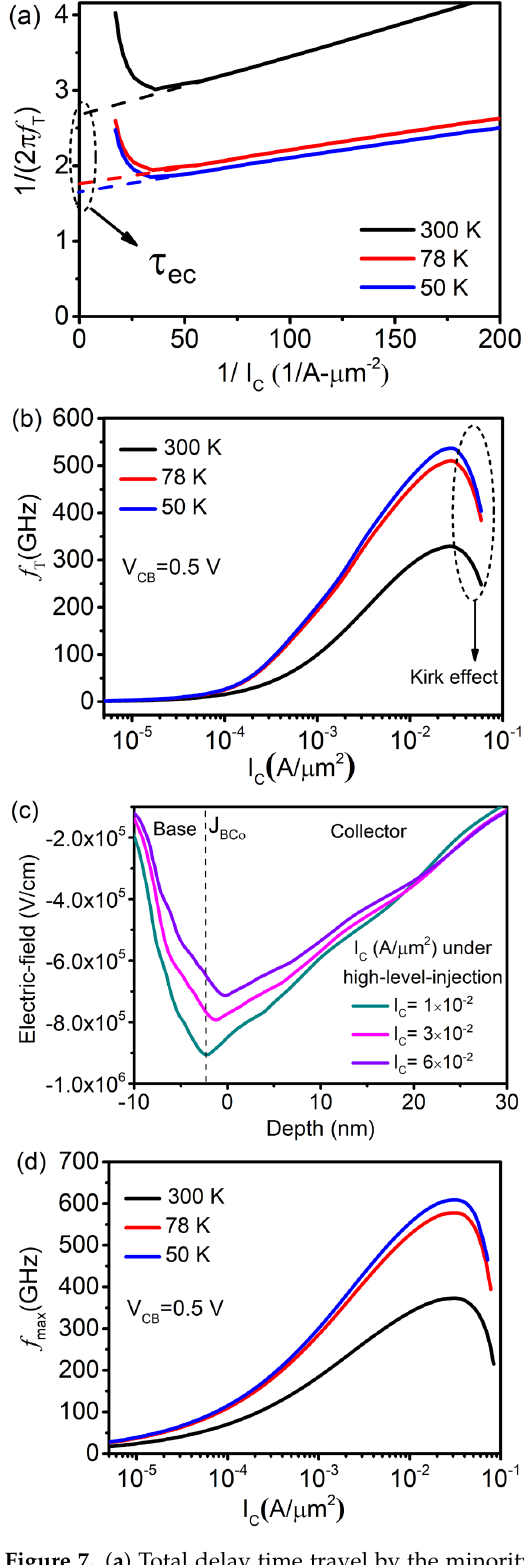
Figure 7. ( a ) Total delay time travel by the minority charge carrier (1/2 π f T ) vs. 1/ I C . The τ ec is extracted with extrapolation of the linear part intersecting at 1 /I C = 0; ( b ) f T (GHz) versus I C ( A/µm 2 ); ( c ) e lectric− field profile at the CB junction at high I C ; and ( d ) f max (GHz) versus I C ( A/µm 2 ).